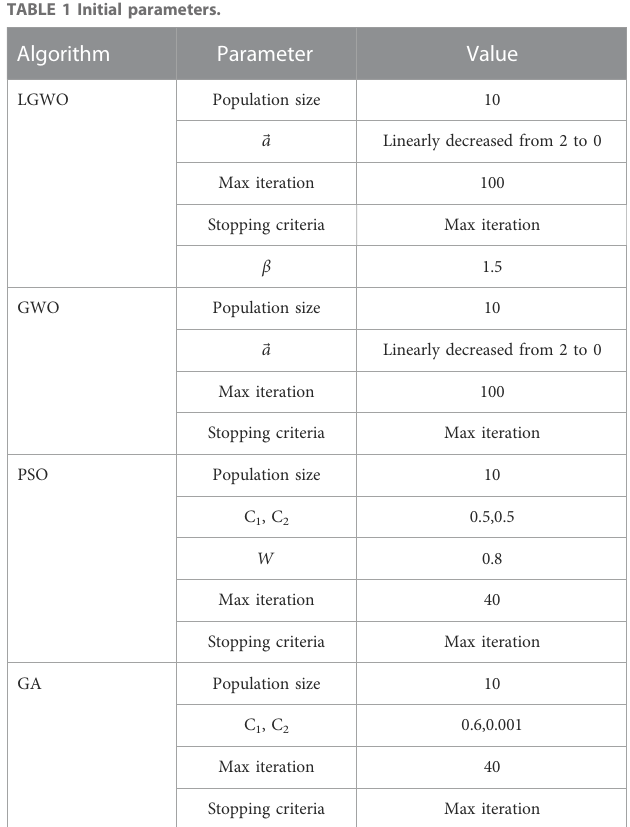
TABLE 1 Initial